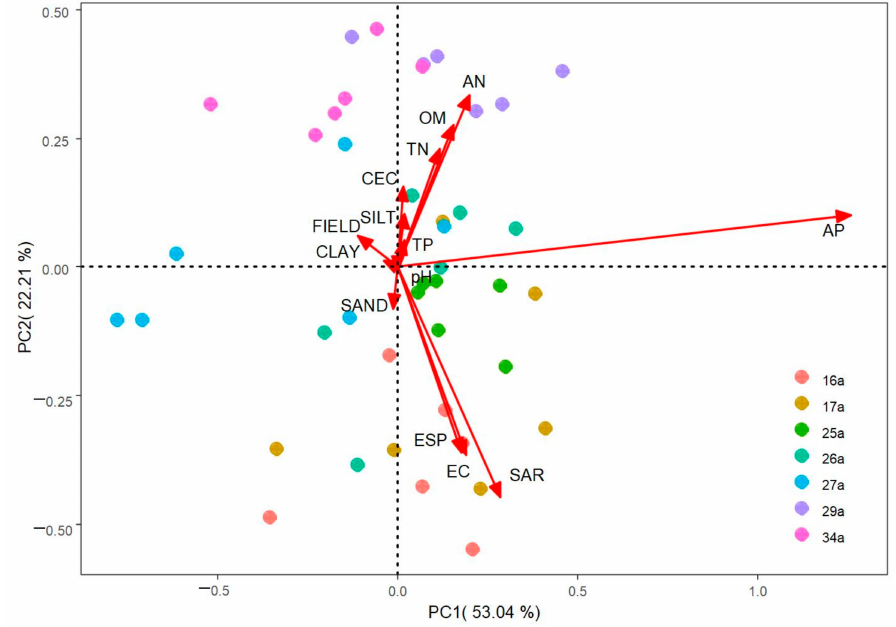
Figure 4. Ordination biplot of the PCA of soil physicochemical properties. The first two axes accounted for 76.71% of the variability in the dataset ( n =